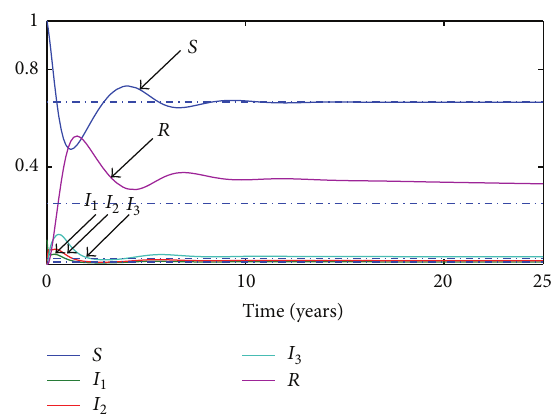
Figure 1: Dynamic of the subpopulations for 𝑅 0 = 1.5 . The dotted lines represent the predicted endemic values.